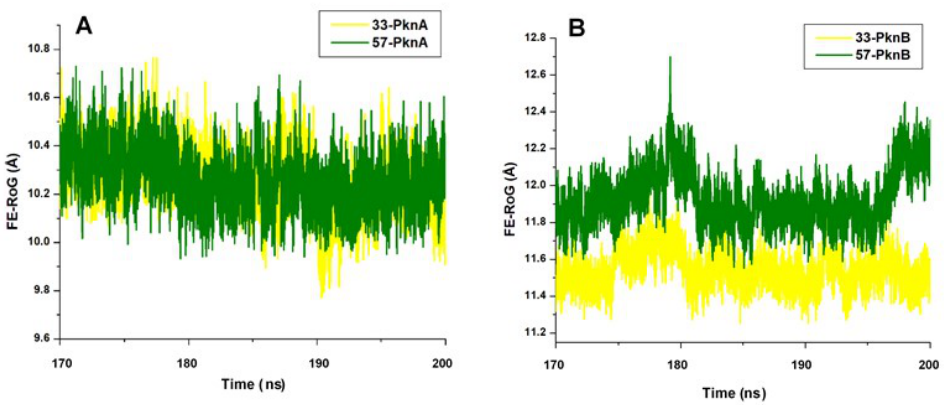
Figure 5. C α RoG plot showing the degree of structural compactness at the NBP of ( A ) PknA-bound 33 Figure 5. Cα RoG plot showing the degree of structural compactness across PknA and PknB NBP and 57 ( B ) PknB-bound 33 and 57 bound by compounds 33 and 57.